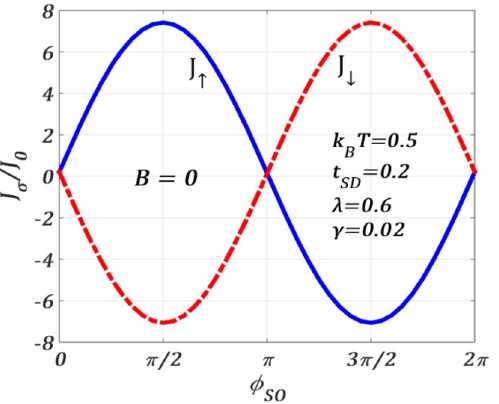
0.5 , (cid:31) 0.6, t SD = =